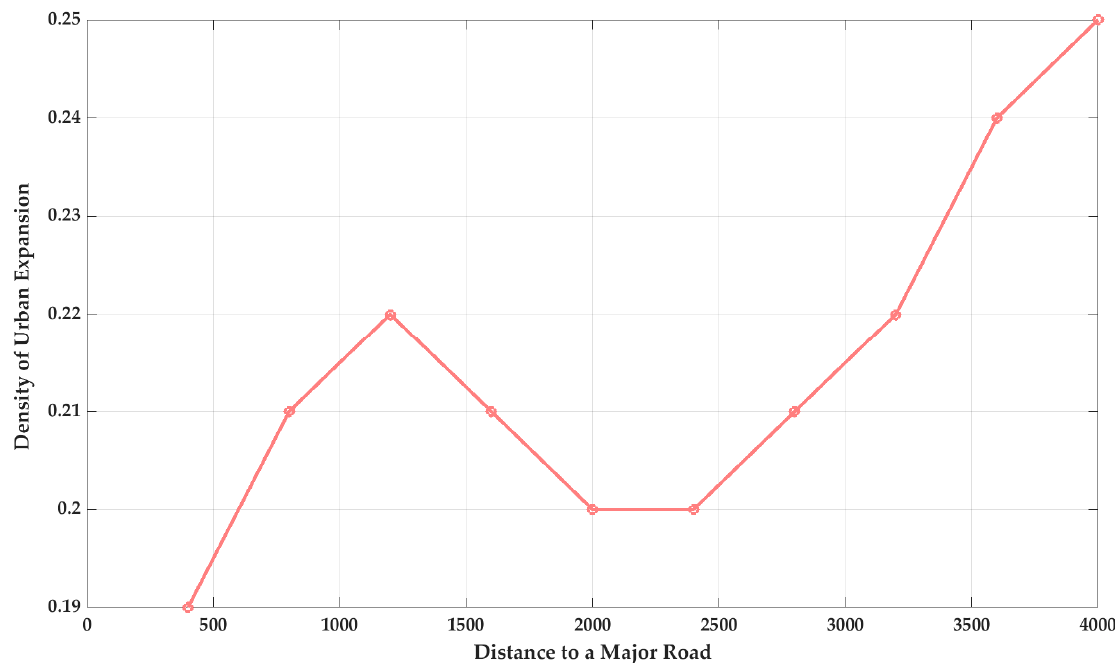
Figure 10. Density Decay Curve.